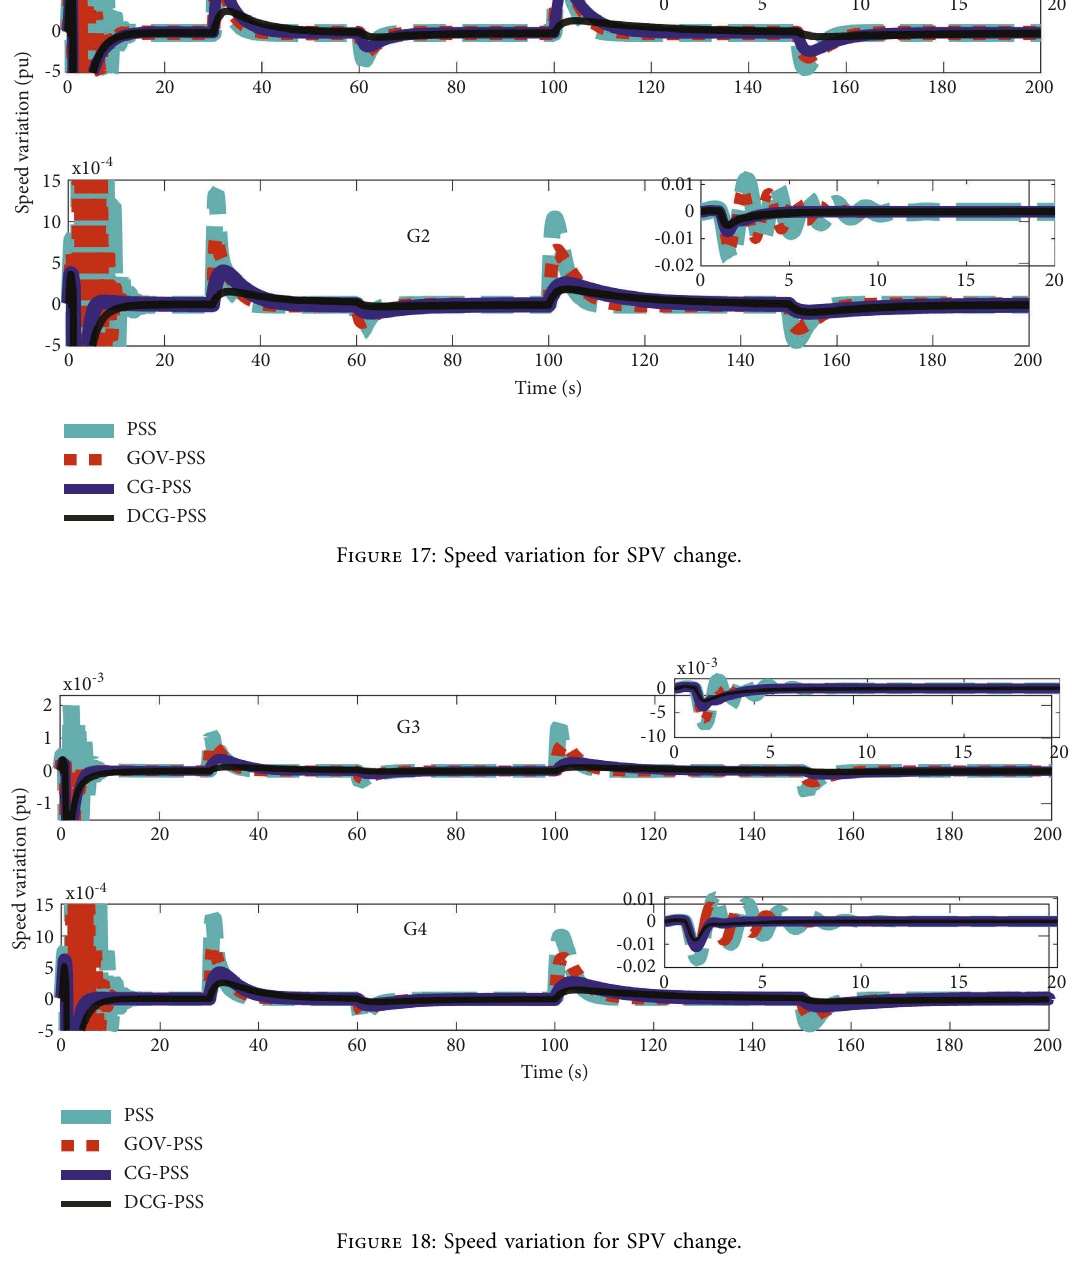
Figure 18: Speed variation for SPV